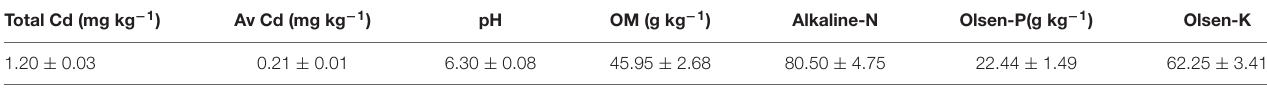
TABLE 1 | Physical-chemical properties of soil in a paddy